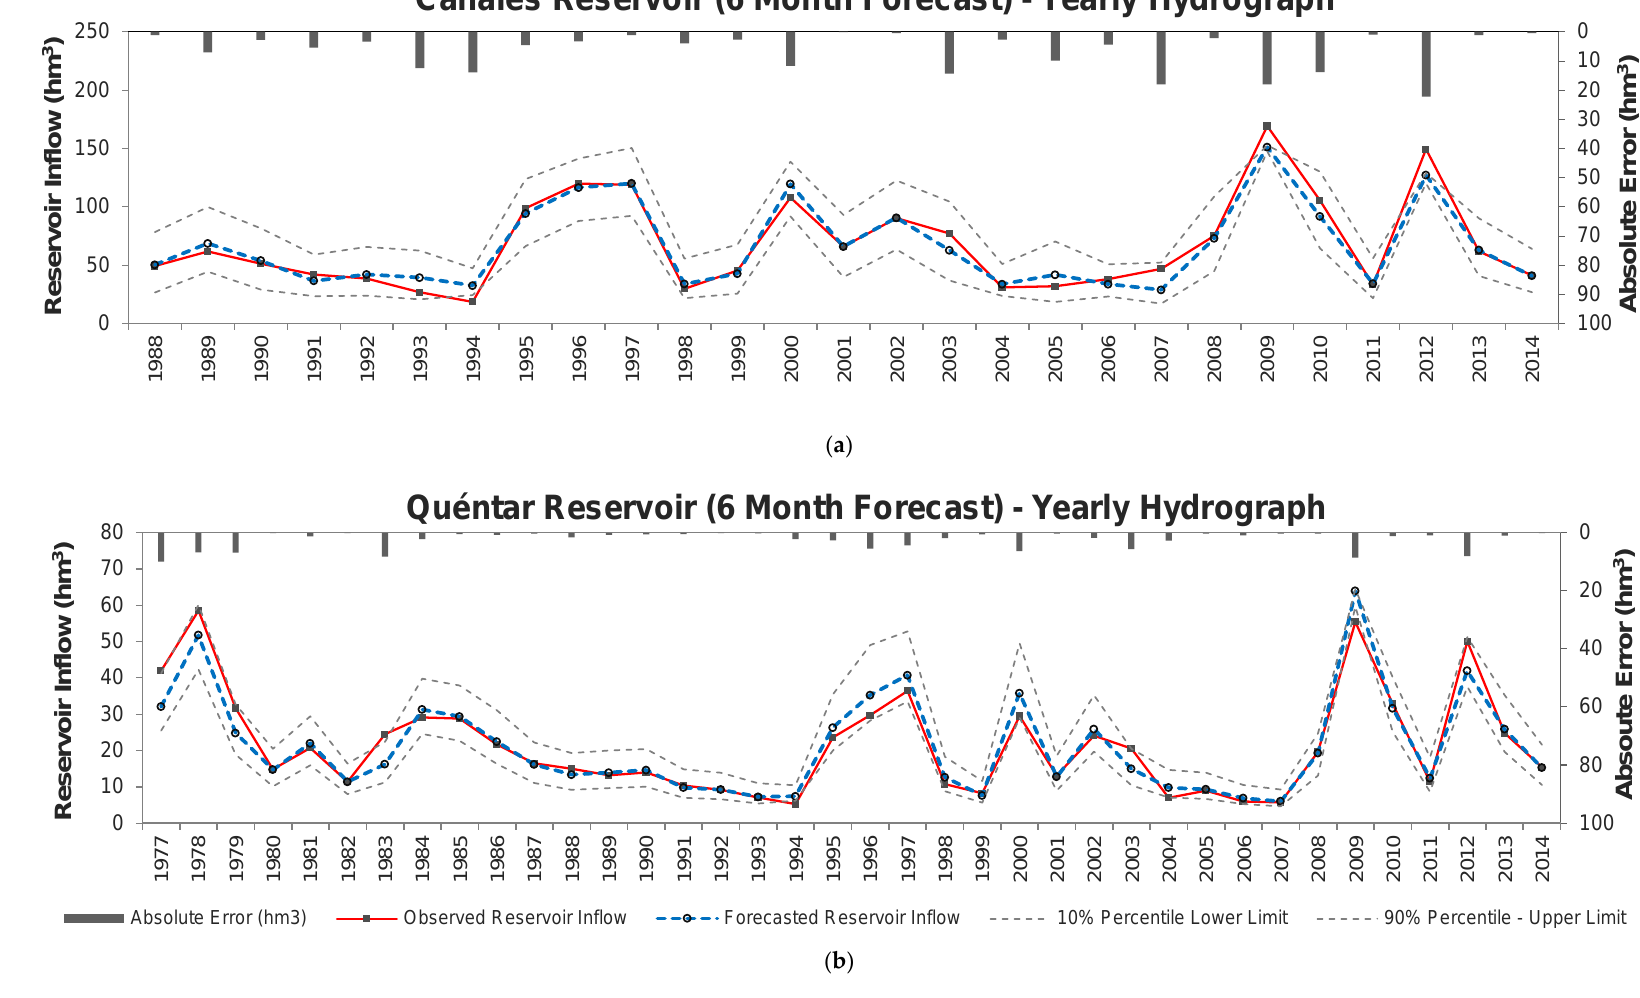
Figure 10. Observed annual streamflows (hm 3 ) and predictions using the model with the first six months of observed data of the hydrological year and 10th and 90th percentiles (lower and upper limits) (hm 3 ) of the ( a ) Canales reservoir and ( b ) Quéntar reservoir